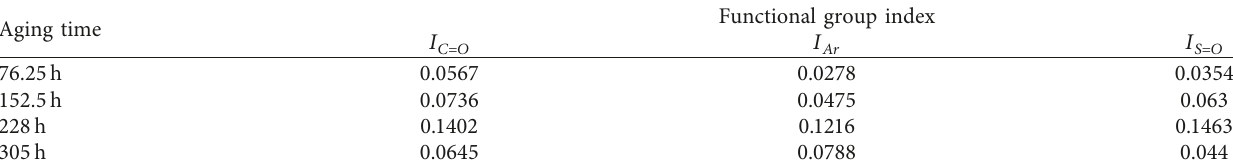
Table 6: Functional group index of ASA-modified asphalt at different UV aging